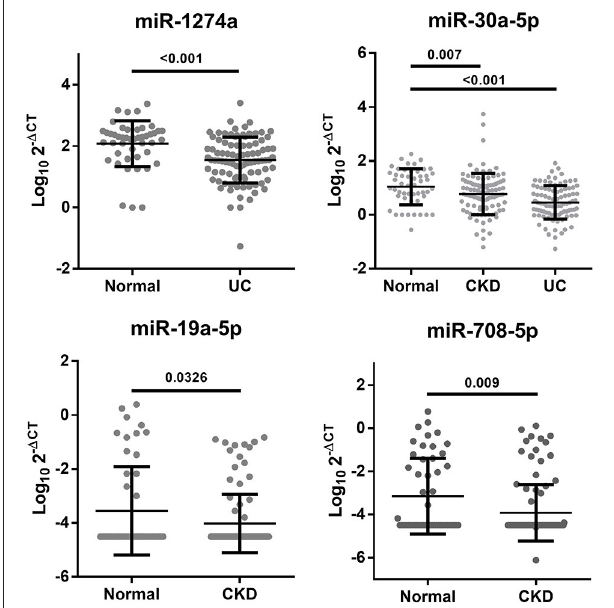
FIGURE 2 | Significant changes in the urine miRNA expression levels between the healthy, CKD and CKD + UC groups. The Y axis presents the expression level (Log102- 1 CT). Healthy, healthy donors. CKD, patients with chronic kidney disease. UC, the urothelial carcinoma patients with CKD. The p -value was analyzed by Student’s t -test for each